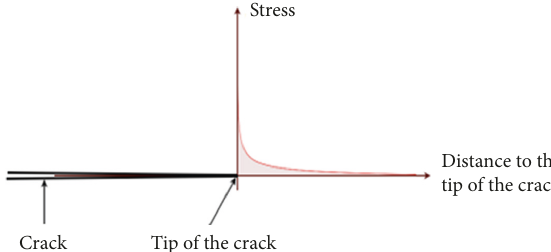
Figure 5: Stress area around the tip of an open crack, in linear